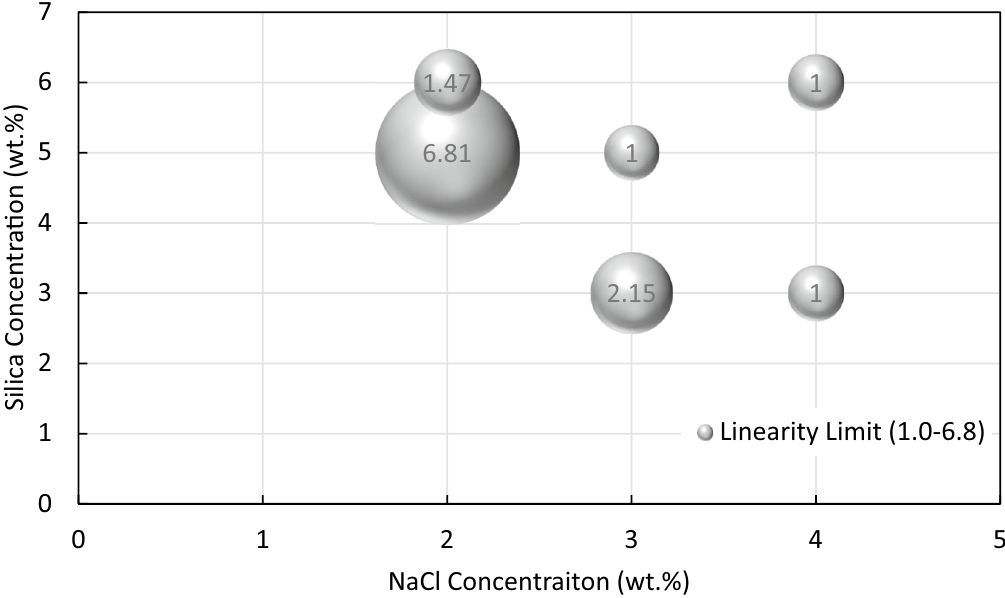
Figure 11. Bubble plot of limits of linear viscoelastic region as shear strain (%) for different solid gels formed from different concentrations of silica and NaCl in DIW at room temperature after 24 h.